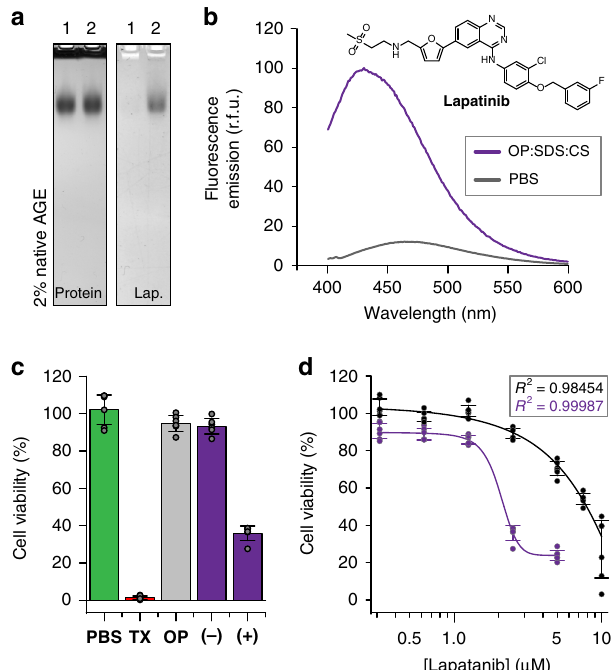
Fig. 5 Stable encapsulation and improved potency of lapatinib. a Native agarose gel of OP:SDS:CS complexes visualized with Coomassie blue for protein (left) and by lapatinib fl uorescence (right). Lane 1 — OP:SDS:CS (1:600:200); Lane 2 — OP:SDS:CS:lapatinib (1:600:200:10). b In the presence of OP:SDS:CS complexes lapatinib fl uorescence increases signi fi cantly and the emission maximum shifts to lower wavelengths, consistent with encapsulation in a nonpolar environment. c Viability of HeLa cells after treatment with 2.5 μ M of free lapatinib ( − ) or lapatinib encapsulated in OP:SDS:CS complexes ( + ). Control samples are PBS buffer, Triton X-100 (TX), and OP:SDS:CS complexes without the encapsulated drug (OP) ( n = 6, error bars: standard deviation). d Dose – response comparison of cell viability after treatment with free lapatinib (black), or lapatinib encapsulated in OP:SDS:CS complexes (purple) ( n = 6, error bars: standard deviation). For each concentration, a loading of 10 lapatinib molecules per capsid was used. Source data are provided as a Source Data fi OP:SDS and OP:SDS:CS complexes (Supplementary Fig. 13). Nevertheless, cargo is still ef fi ciently released from the capsid after